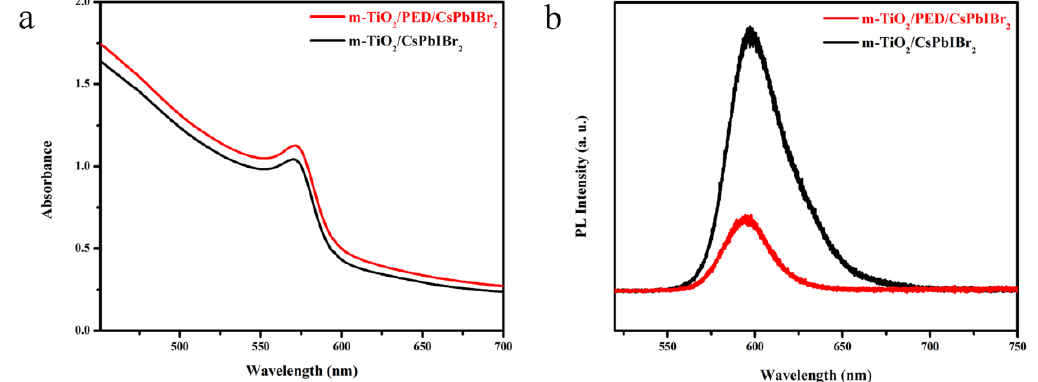
Figure 4. ( a ) UV-vis absorbance spectra and ( b ) photoluminescence (PL) spectra of the m-TiO 2 /CsPbIBr 2 films with and without PED modification.